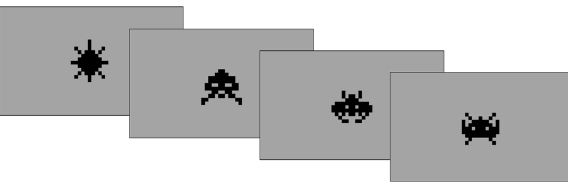
Figure 5. The stimuli in the gamified n -back